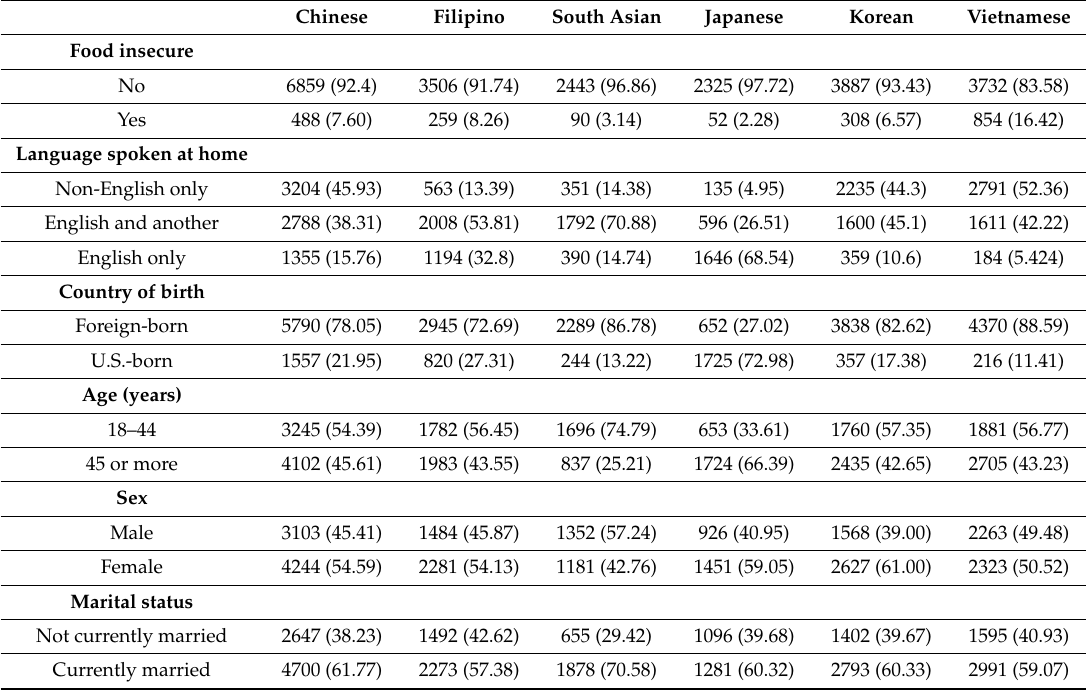
Table 1. Study population characteristics by Asian American